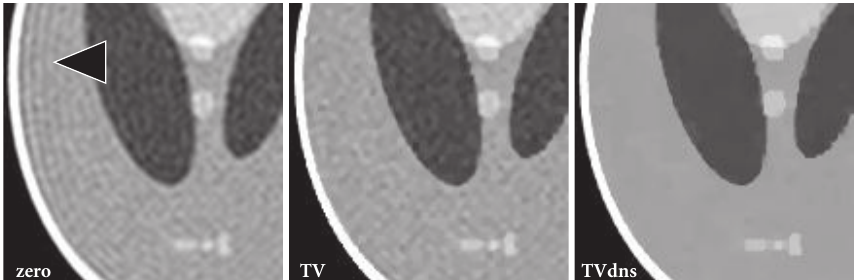
Figure 5: Images of the numerical Shepp-Logan phantom reconstructed from noisy data (96 × 96 samples, 288 × 288 reconstruction matrix) using zero-padding (zero), the proposed extrapolation method (TV), and the proposed method combined with denoising (TVdns). Arrow = truncation artifact.